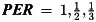
PSNR and SSIM plots in each energy channel when PER = 1,12,13 respectively without data noise.